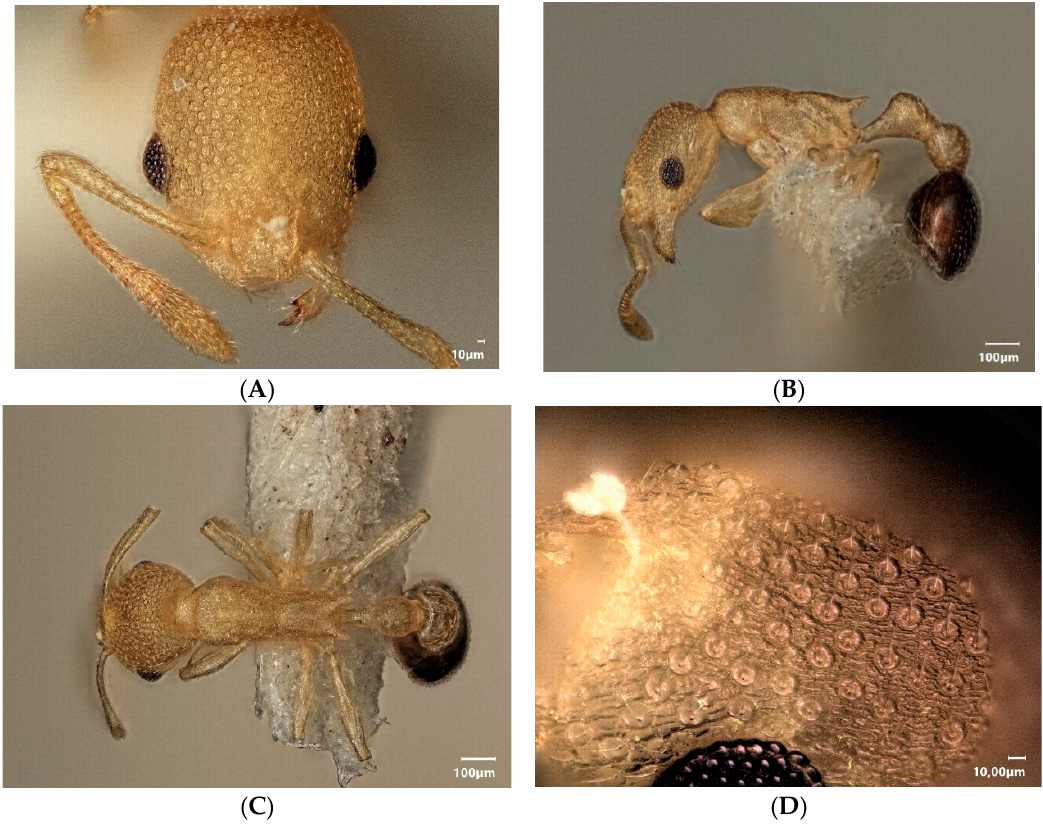
Figure 16. Cardiocondyla nivalis : head in dorsal view ( A ), lateral view ( B ), dorsal view ( C ), vertex median of the eye ( D ).